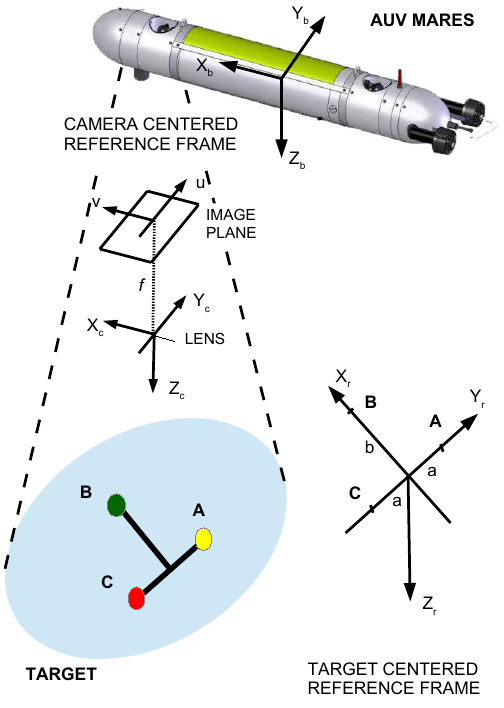
Figure 4. Definitions of the camera and target reference frames for relative localization.